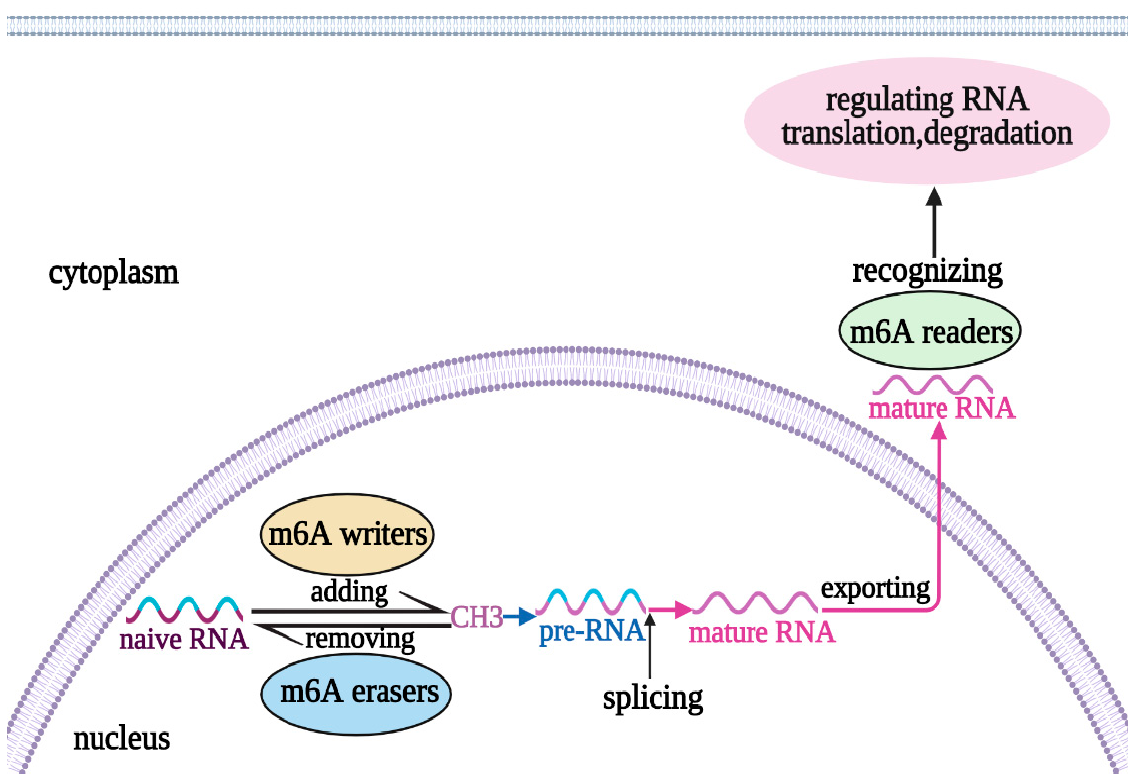
Figure 1. Mechanism of RNA m6A Modification. The process of m6A modification on RNA consists of adding and removing a methyl group by writers and erasers to form pre-RNA and then splicing to form the mature RNA, respectively. Finally, the mature RNA was nuclear-exported, and recognized by readers to regulate RNA translation and degradation. m6A, N6-methyladenosine.CH3, methyl group.